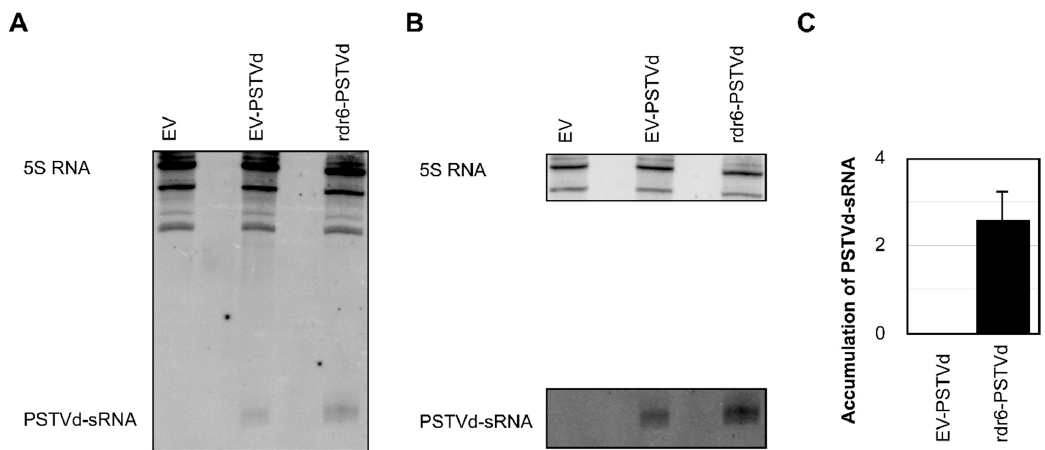
Figure 3. Di ff erential PSTVd-sRNA accumulation in N. benthamiana plants. ( A ) Total RNA extracted from N. benthamiana plants at 21-dpi was used to monitor the PSTVd-sRNA levels by RNA gel blot assay using a radiolabeled PSTVd riboprobe. The 5S rRNA was used as a loading control. ( B ) A di ff erent contrast than was used in ( A ) so as to permit better visualization of the pertinent bands. ( C ) The gel blot signals were quantified and expressed as a ratio of the PSTVd-sRNA to the 5S rRNA signals. For each set of experiments, the ratios of target RNA to 5S rRNA obtained with EV-PSTVd inoculated plants were set at a value of zero. The error bars indicate the standard deviations (SD). EV-PSTVd, plants agroinfiltrated with pTRV2-EV vector and infected with PSTVd-RG1; rdr6-PSTVd, plants agroinfiltrated with pTRV2-RdR6 vector and infected with PSTVd-RG1. Each experiment was performed at least three times with true biological replicates.